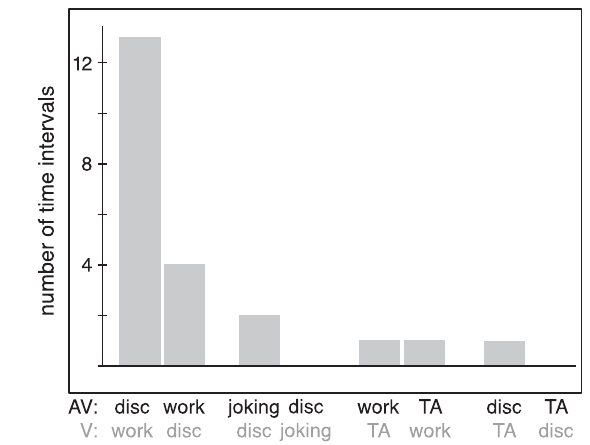
FIG. 2. Code disagreements. Code disagreements occur at time intervals when the codes chosen in the V and AV modes differ. The AV mode coders are more likely to have consensus on discussion when the V mode coders have consensus on work- sheet, and vice versa. Also, the AV mode coders are slightly more likely than the V mode coders to recognize an interaction as joking. Combinations of codes not shown above did not have code